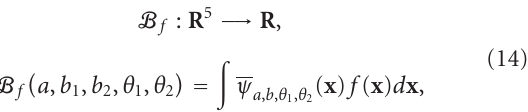
Figure 8: Example of beamlet function.